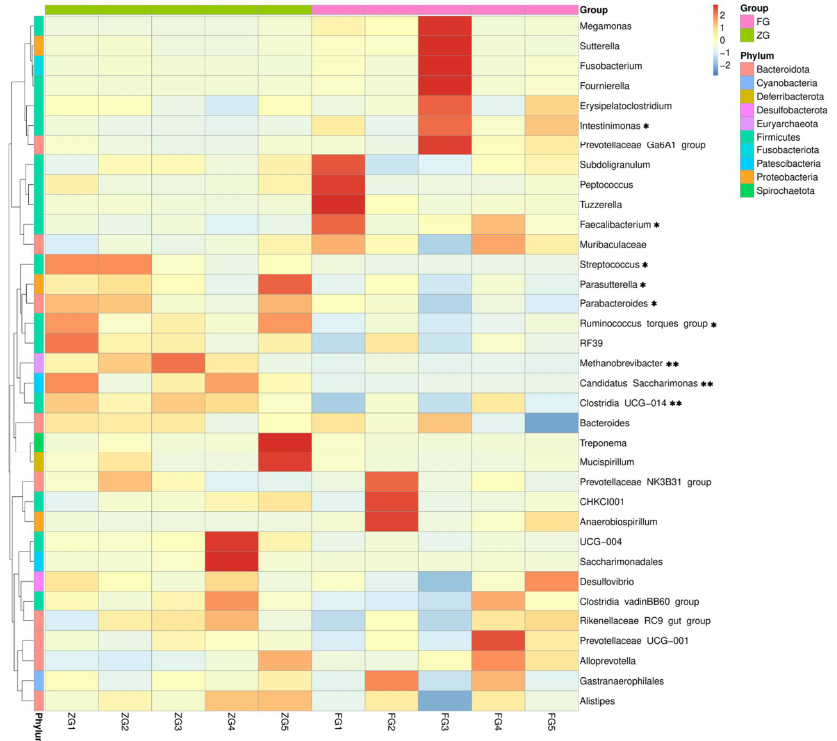
Figure 4. Heatmap of major genera of cecal microbiota. * p < 0.05 and ** p < 0.01 indicate significant differences between the ZG and FG. ZG, Zi goose; FG, Xianghai flying goose.